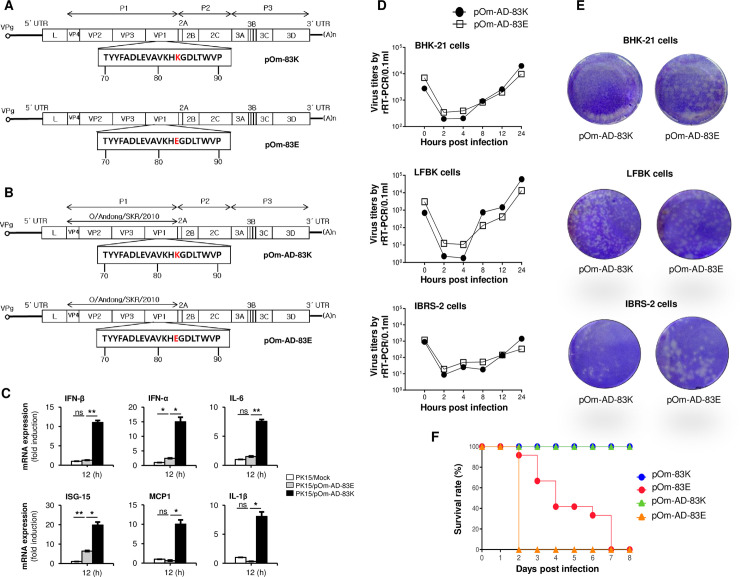
Construction and characterization of the chimeric virus.(A and B) Schematic depiction of the chimeric viruses. The chimeric clones pOm-83E and pOm-AD-83K have replaced the 83rd amino acid with 83E or 83K through point mutation, respectively. (C) PK15 cells were infected with pOm-AD-83K and pOm-AD-83E (0.05MOI), together with mock infection. At 12hpi, cells were harvested and analyzed by quantitative real-time PCR analysis for IFN-β, IFN-α, IL-6, ISG-15, MCP1, and IL-1β genes. (D) The pOm-AD-83K and pOm-AD-83E chimeric virus were infected to BHK-21, LFBK, and IBRS-2 cells. At the indicated time points virus titer was determined by RNA extraction and quantitative real-time PCR analysis. (E) BHK-21, LFBK, and IBRS-2 cells were infected with each virus at 105.0~101.0 TCID50/0.1mL with 10-fold dilutions and stained with crystal violet at 72h after virus infection. The images show the wells inoculated with each virus at 103.0 TCID50/0.1mL. (F) For the comparison of pathogenesis in suckling mice (n = 10), the survival rate was determined after challenge with recombinant FMDVs intraperitoneally. In C, data are representative of two independent experiments, each with similar results and all the values are expressed as mean ± SD of two biological replicates. Student’s t test; *p < 0.05; **p < 0.01; ***p < 0.001; ns, not significant.